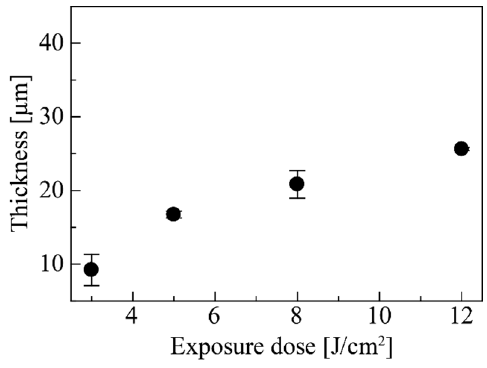
Figure 9. Change in exposed thickness of composite.